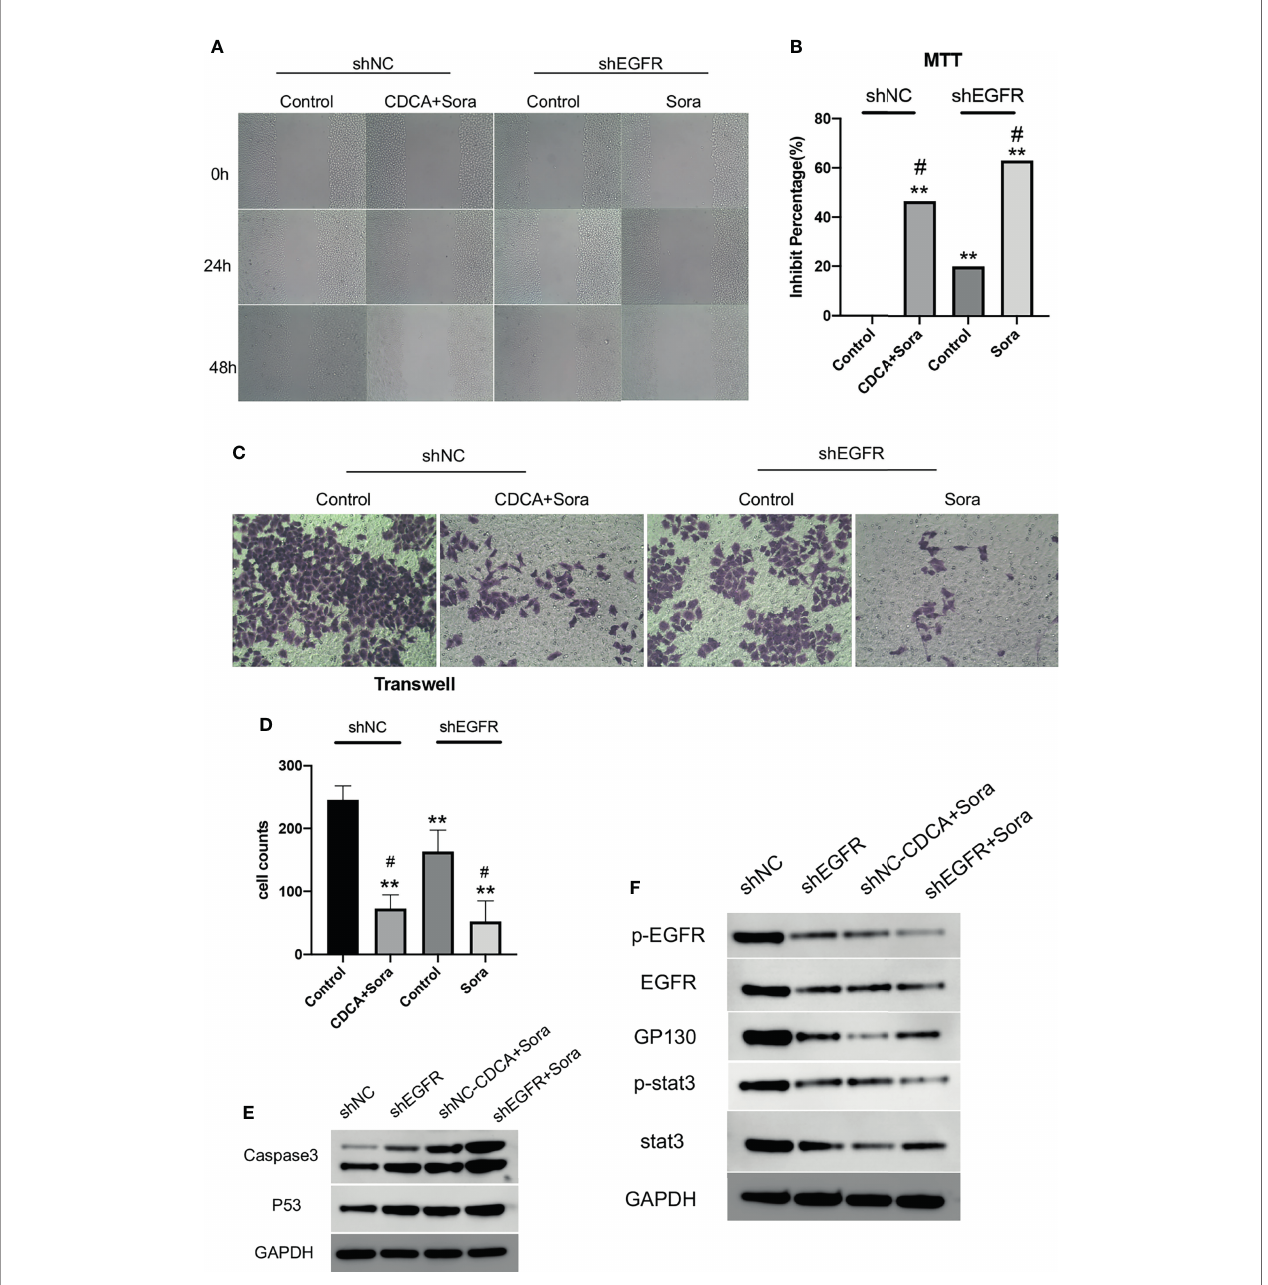
FIGURE 6 | CDCA inhibits EGFR in vitro . After knockdown of cellular EGFR, intervention with the same dose of CDCA and sorafenib as before. (A) Cell scratch assays at 0, 24, and 48 h after intervention (10x). (B) MTT results. ** P < 0.01 vs. shNC-Control, # P < 0.05 vs. shEGFR-Control. (C) Crystalline violet staining to observe cell proliferation before and after EGFR knockdown (20x). (D) Transwell assay results. (E) Effect of CDCA on apoptotic protein caspase 3 and p53 expression before and after EGFR knockdown. (F) EGFR and STAT3 protein and phosphorylation levels before and after EGFR